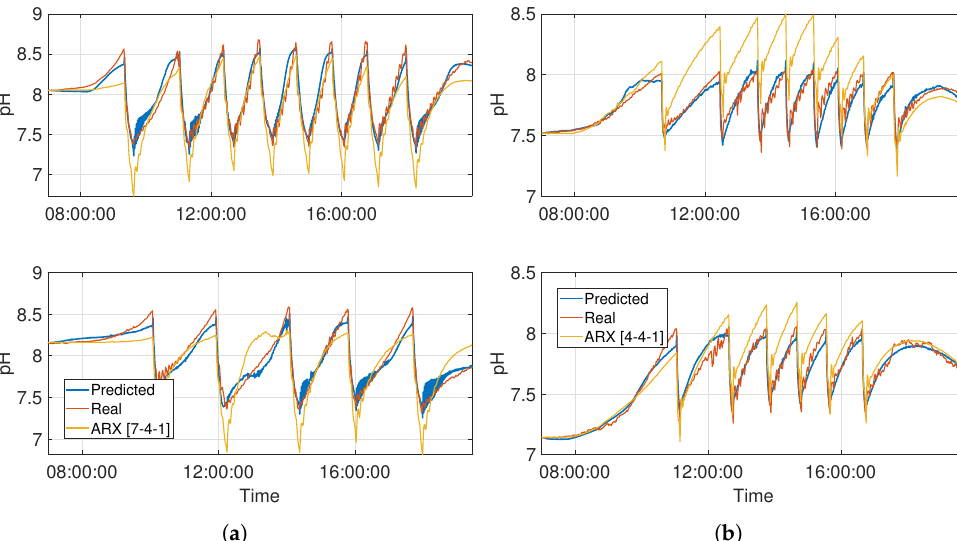
Figure 4. Validation results for each of the models using two days of the test set. ( a ) Freshwater model validation results, ( b ) Wastewater model validation